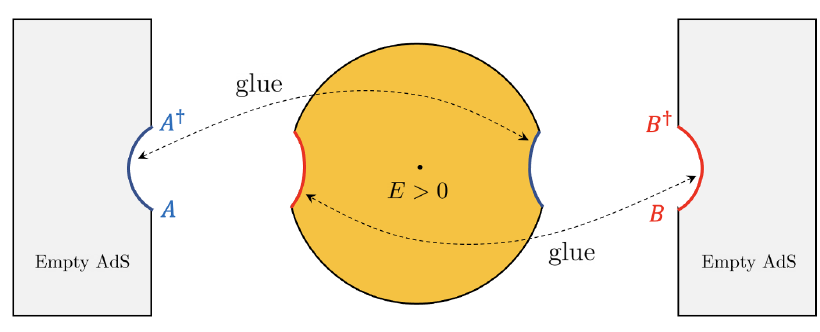
Figure 6 . First attempt for a